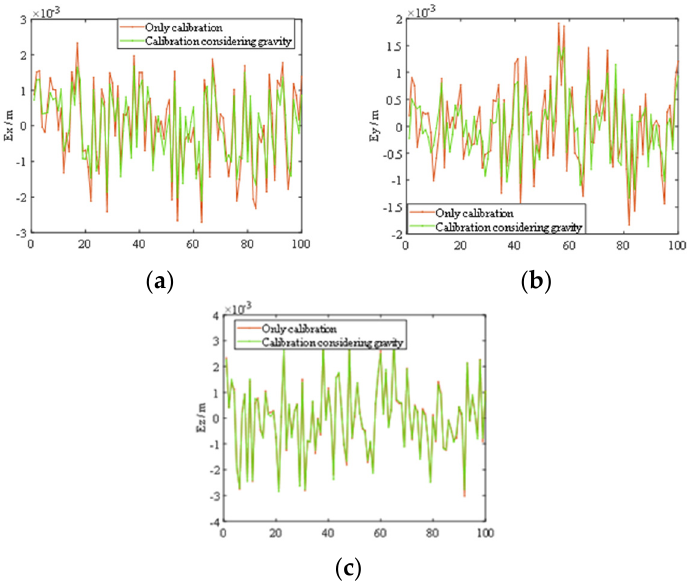
Figure 14. Verification of kinematic calibration only in X- ( a ), Y- ( b ), and Z- ( c ) directions. After calibration considering gravitational deformation, the compensated error, the error obtained by calibration without considering gravity, and the error obtained by only calibration of each measurement point were compared using the identified parameters, as shown in Figure 15 and tabulated in Table 5.